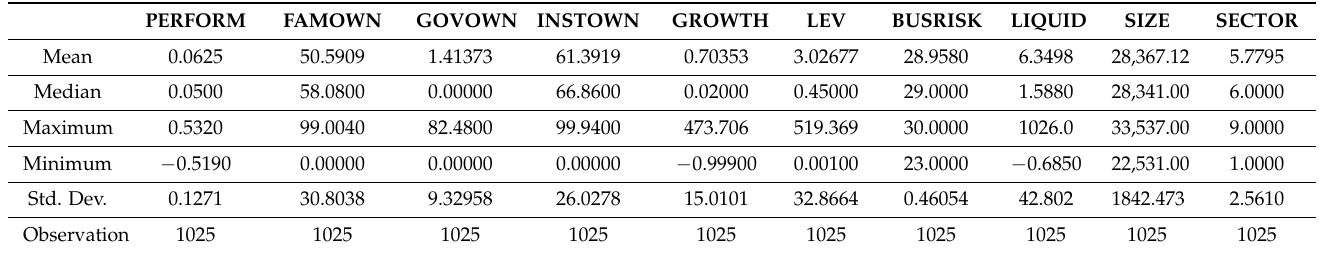
Table 2. Descriptive statistics.